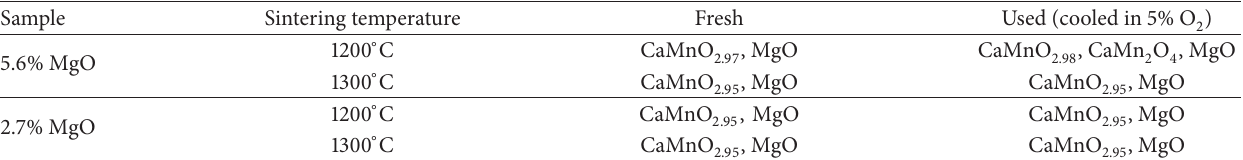
Table 7: Crystalline phases identified in investigated